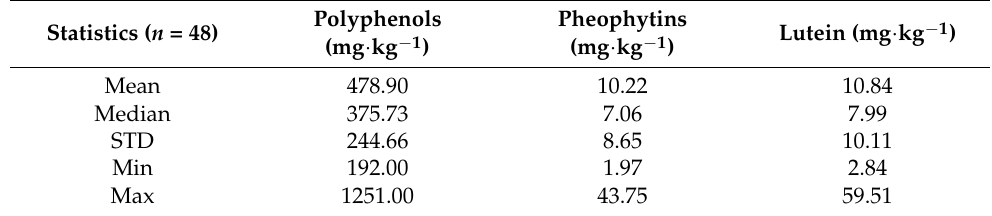
Table 1. Summary of the basic statistics of reference measurements of polyphenols and pigments for the calibration and the validation